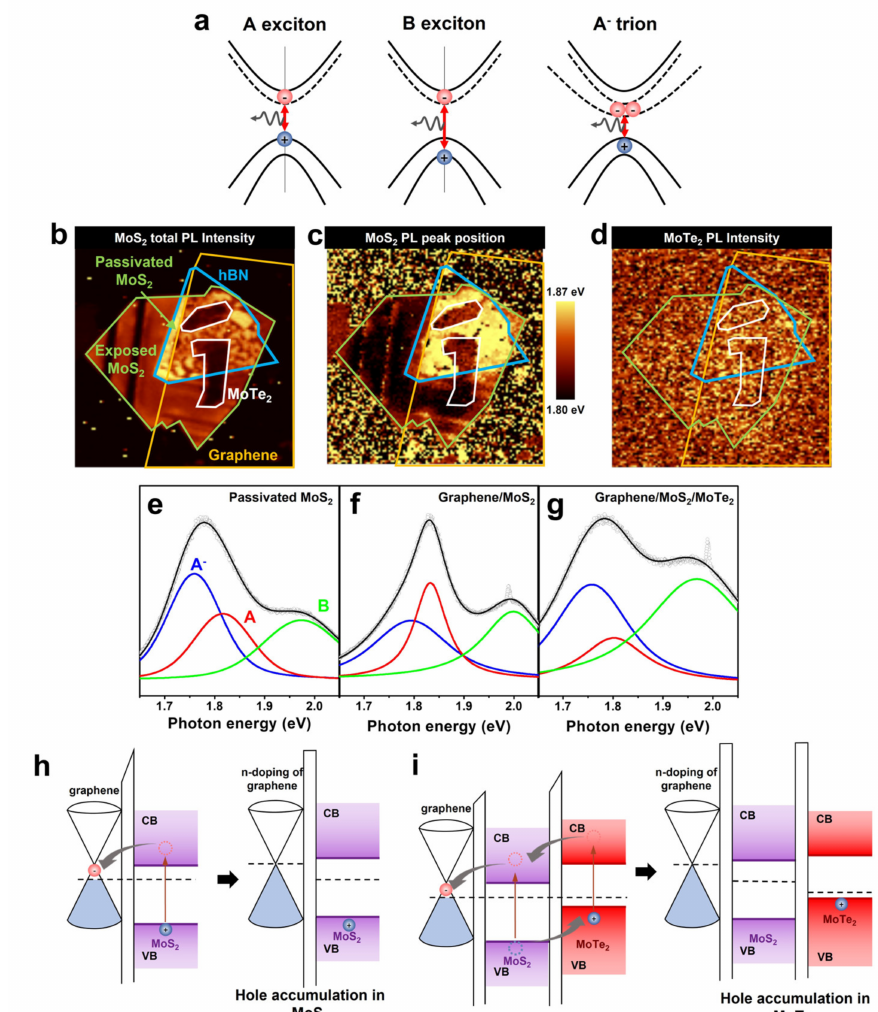
Figure 3. ( a ), Schematics showing A exciton ( left ), B exciton ( middle ), and A − trion ( right ) in MoS 2 . ( b ), MoS 2 PL intensity map and ( c ), PL peak position map. ( d ), MoTe 2 PL intensity map. ( e ), PL spectra of MoS 2 in MoS2-only region (passivated by hBN), ( f ), graphene/MoS 2 region, and ( g ), graphene/MoS 2 /MoTe 2 region. ( h ), Energy band diagrams of graphene/MoS 2 , and ( i ), graphene/MoS 2 /MoTe 2 before ( left ) and under illumination ( right